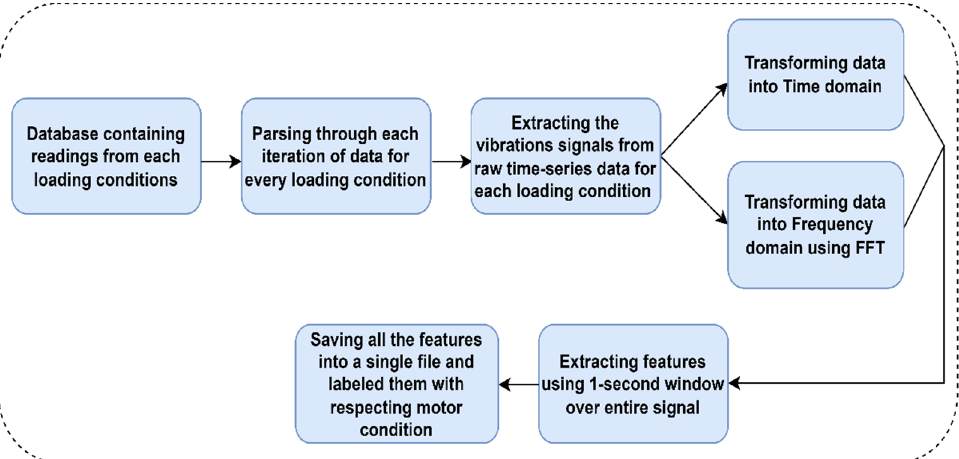
Figure 3. Steps involved in feature extraction in the time domain and frequency domain from raw data.